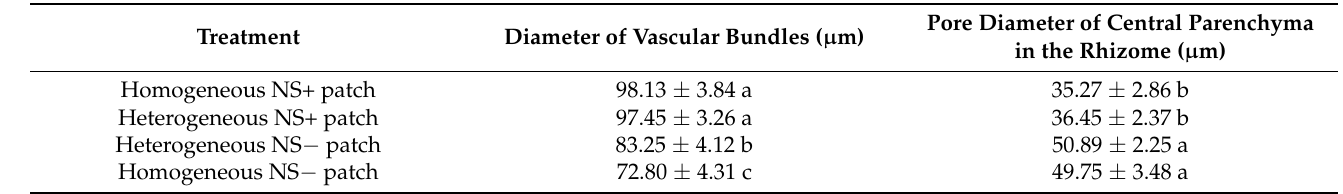
Figure 4. Rhizome crosscutting structures of Kentucky bluegrass ramets in different patches under different water treatments (60×). ( A ) Homogeneous NS+ patch; ( B ) heterogeneous NS+ patch; ( C ) heterogeneous NS− patch; ( D ) homogeneous NS− patch; E: epidermis; VB: vascular bundle; PT: central parenchyma. Table 3. Comparison of the rhizome crosscutting structures of Kentucky bluegrass ramets in different patches under different treatments.